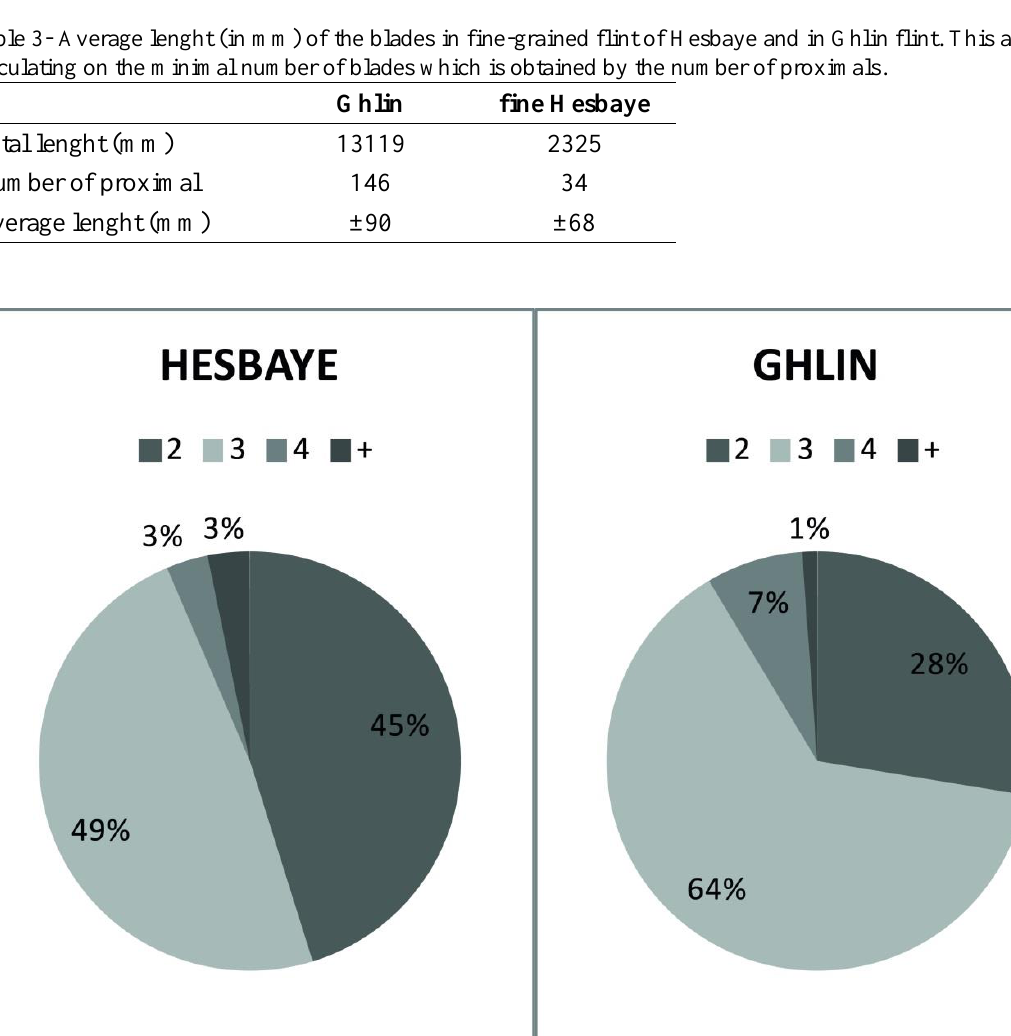
Figure 9. Comparisons between the sections of the blades in Ghlin flint (n=174) and in fine-grained flint of Hesbaye (n=31). 2 : 2 facets (triangular blades), 3 : 3 facets (trapezoidal blades), 4 : 4 facets, + : 5 facets and